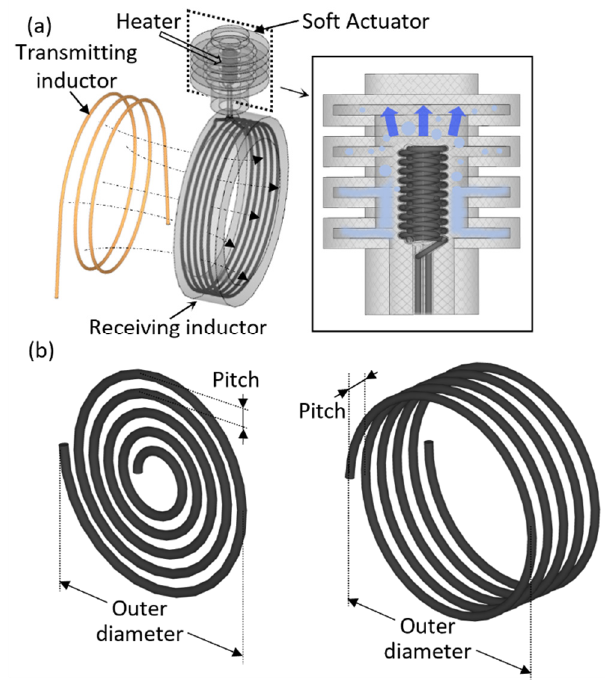
Figure 1. Schematics diagram of a wireless micro soft actuator: ( a ) Wireless power transfer and the following expansion of the micro soft actuator by liquid–gas phase change of working fluid inside the actuator . ( b ) Multi-turn coils with two-dimensional spiral structure (left) and three-dimensional helical structure (right).